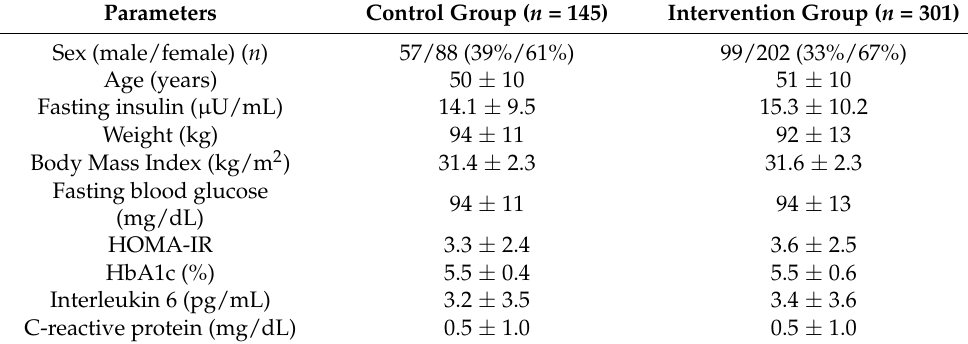
Table 1. Baseline